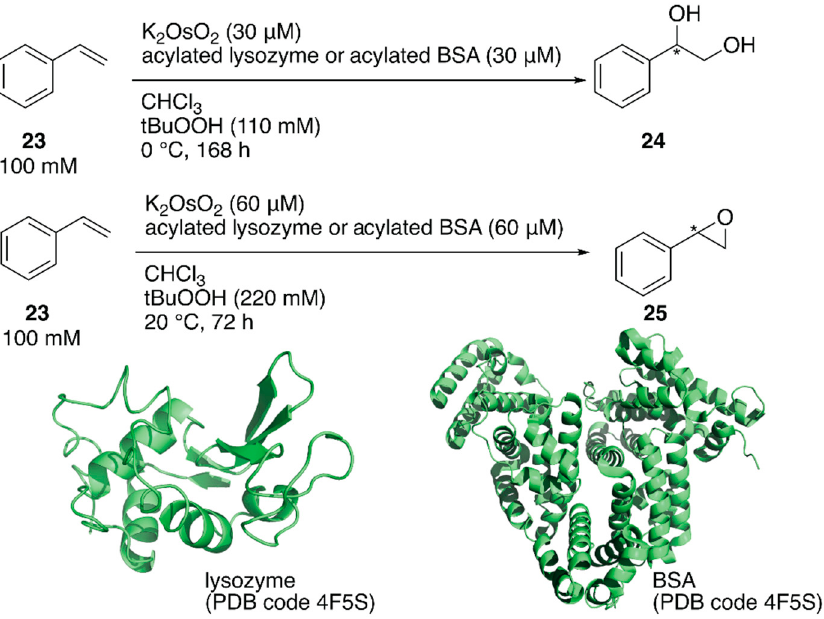
Figure 5. Oxidation reactions catalyzed by acylated protein-bearing Os ions in organic solvents. Adapted from [47]. Table 2. Selected results of oxidation reactions catalyzed by acylated protein-bearing metal ions in organic solvents [47].